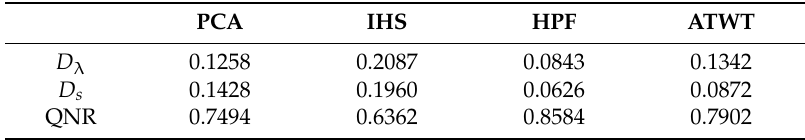
Table 3. QNR, D λ and D s indexes of the sharpened SWIR band and Band 8A generated by PCA, IHS, HPF and